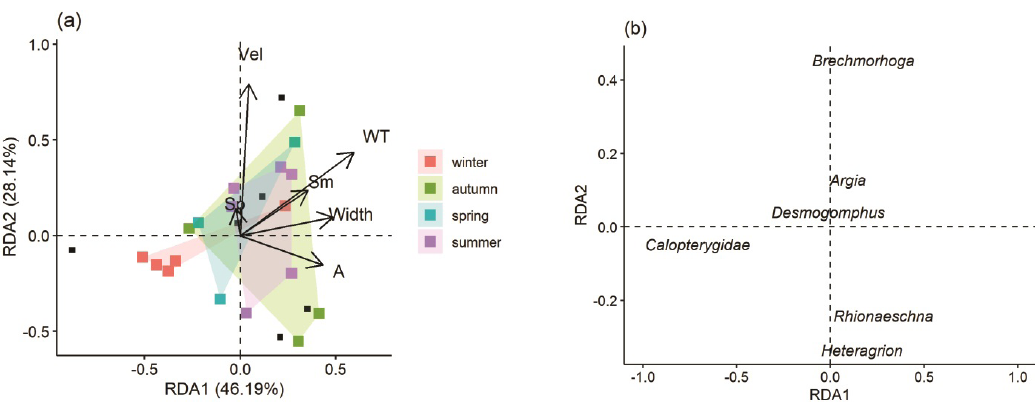
Figure 4. Redundancy Analysis ordination diagrams displaying the relationship of environmental drivers and the composition of odonate assemblages. a) triplot of environmental drivers (arrows), odonate taxa (dark squares) and sampling sites (colored according to the seasons); b) distribution of odonate taxa in the canonical space. The location of the filled squares in (a) corresponds to the location of the names of the odonate taxa in (b). Abbreviations in (a): Vel = stream velocity; WT = water temperature; Width = stream channel width; Sp = spring; A = autumn; Sm =